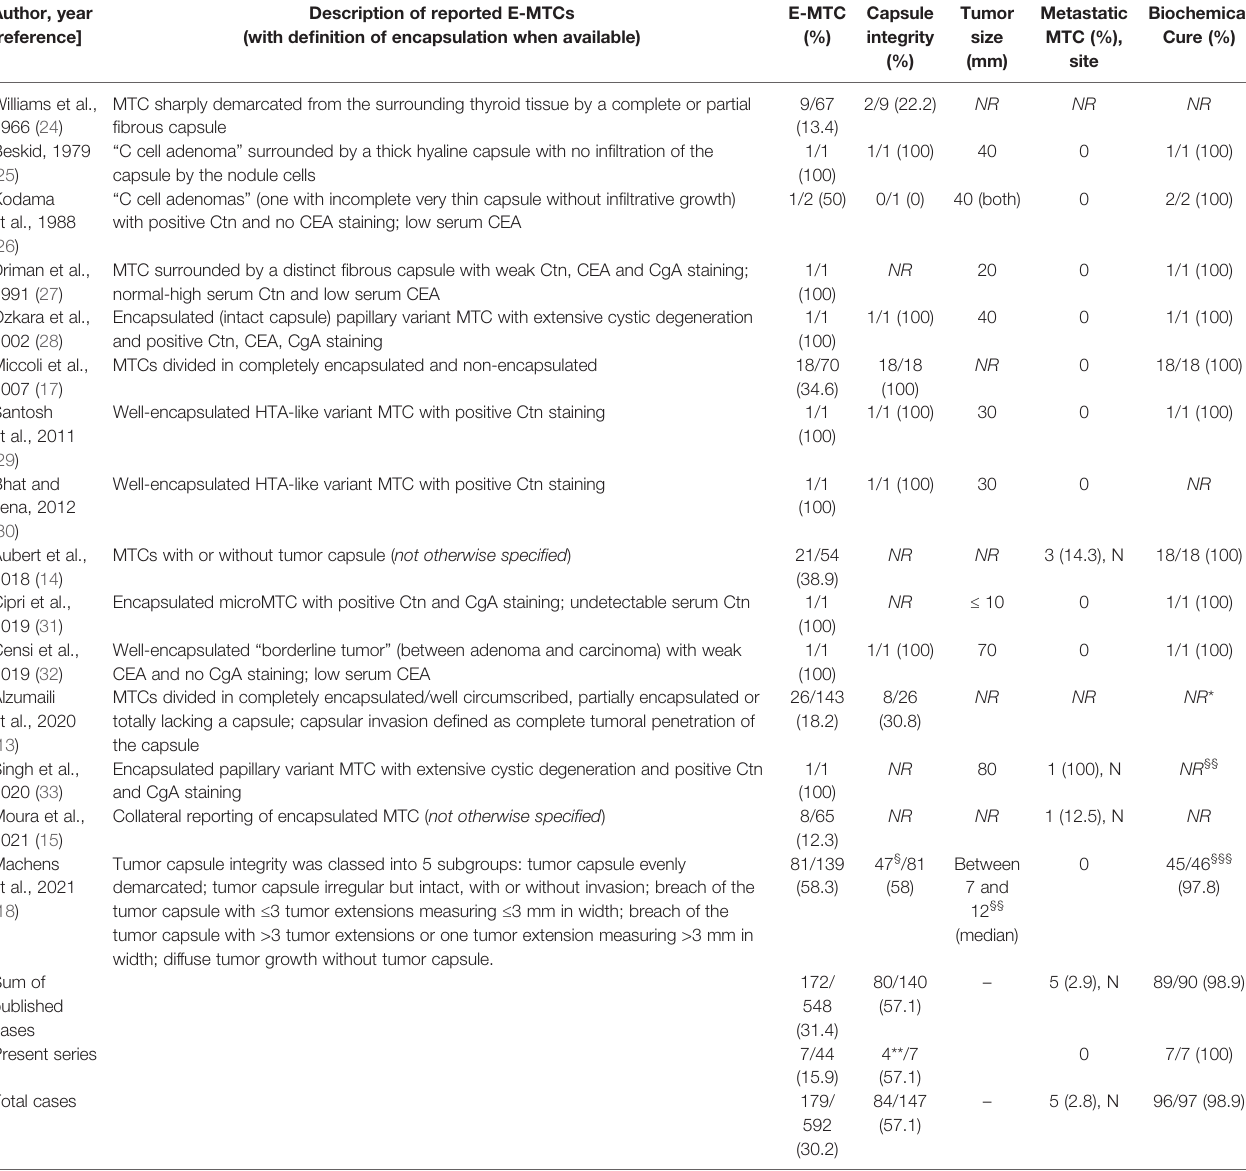
Tumor capsule integrity was classed into 5 subgroups: tumor capsule evenly demarcated; tumor capsule irregular but intact, with or without invasion; breach of the tumor capsule with ≤ 3 tumor extensions measuring ≤ 3 mm in width; breach of the tumor capsule with >3 tumor extensions or one tumor extension measuring >3 mm in width; diffuse tumor growth without tumor